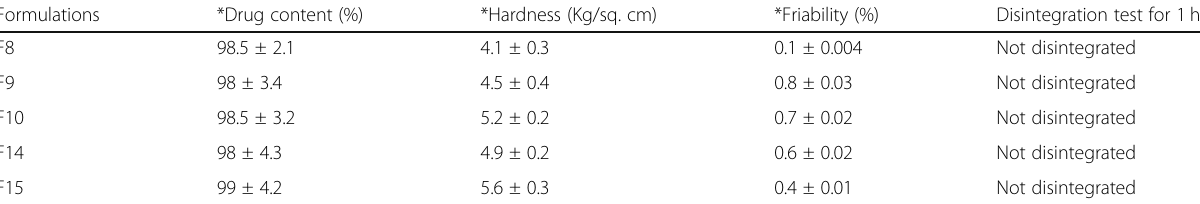
Table 5 Quality control tests of minitablets Formulations